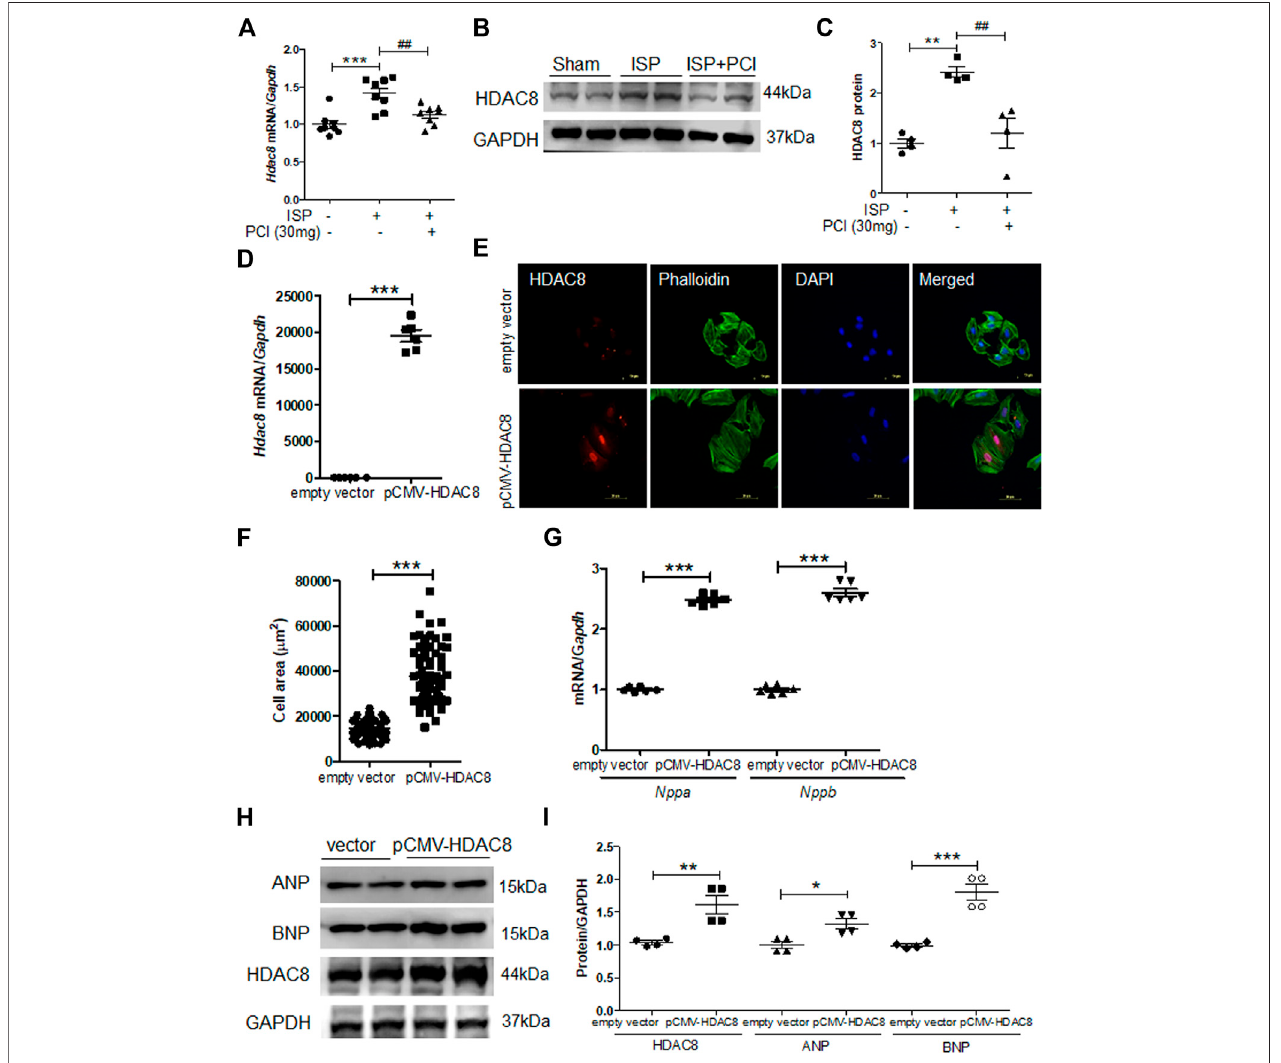
FIGURE4| OverexpressionofHDAC8inducescardiachypertrophyinH9c2cells (A) mRNAexpressionlevelsofHDAC8inhearttissuesfromsham,ISP,andISP+ PCI34051 (30 mg/kg/day)-treated mice ( n (cid:2) 8). *** p < 0.001; ## p < 0.01 from one-way ANOVA followed by Bonferroni post hoc tests (B-C) Western blot analysis of HDAC8 and GAPDH (loading control) from the samples described in (A) (B) Representative blots (C) Quanti fi cation of HDAC8 ( n (cid:2) 4). ** p < 0.01; ## p < 0.01 from one- way ANOVA followed by Bonferroni post hoc tests (D) H9c2 cells were transfected with pCMV6-HA-Myc or pCMV6-HDAC8-HA-Myc for 48 h Hdac8 mRNA expressionlevels.*** p < 0.001fromtheStudent ’ s t test (E) Thetransfectedcellswere fi xedandstainedusinganti-HDAC8antibodyandAlexaFluor488phalloidin.Scale bar (cid:2) 50 μ m. Red, green, and blue indicate HDAC8, actin fi laments, and nuclei, respectively (F) Quanti fi cation of cell size ( n (cid:2) 70 – 75). *** p < 0.001 from the Student ’ s t test (G) Nppa and Nppb mRNA expression levels in these cells ( n (cid:2) 6). *** p < 0.001 from the Student ’ s t test (H) Western blot analysis for ANP, BNP, and HDAC8. Representative blots (I) Quanti fi cation of HDAC8, ANP, and BNP protein levels ( n (cid:2) 4). * p < 0.05, ** p < 0.01, and *** p < 0.001 from the Student ’ s t